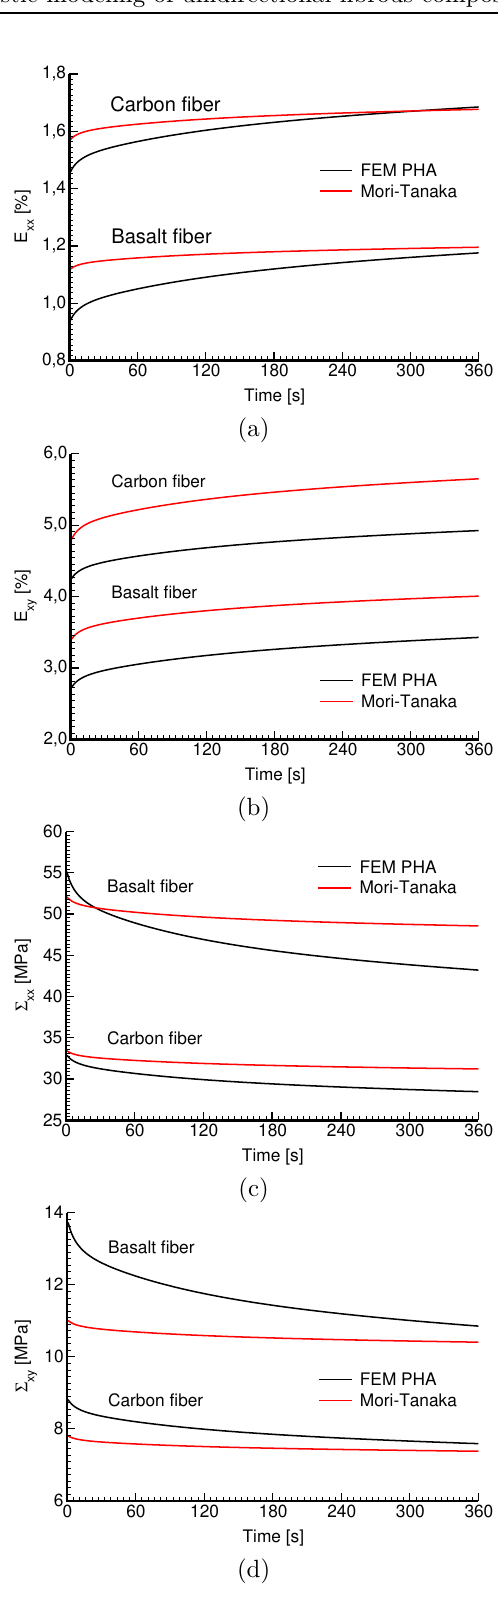
Figure 6. Comparison of macroscopic response pre- dicted by finite element simulations and Mori-Tanaka method for both basalt carbon fiber composites: (a-b) creep test, (c-d) relaxation test - a) Σ xx prescribed, b) Σ xy prescribed, c) E xx prescribed, d) E xy pre-